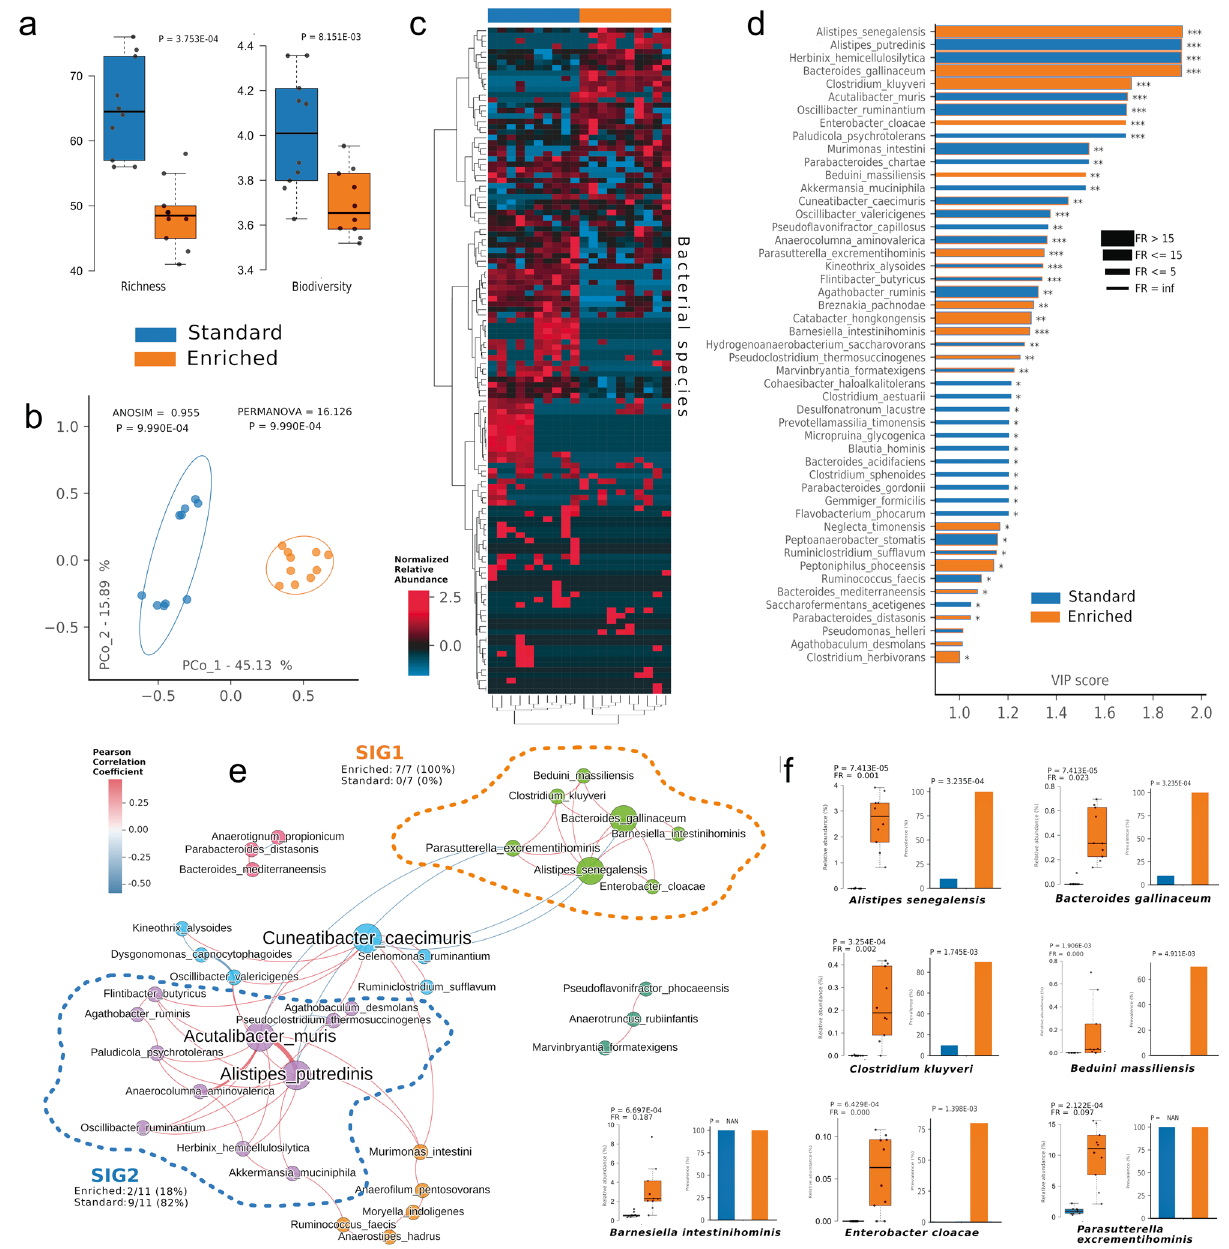
Fig. 1 Fecal microbiota composition in EE and SE mice. Alfa-diversity ( a ) shows differences in both richness (number of bacterial species) and biodiversity (Shannon metric) among standard (SE, blue, n = 10 biologically independent samples) and enriched mice (EE, orange, n = 10 biologically independent samples). Beta-diversity ( b ) and Hierarchical Clusterization Analysis (HCA, c ), following the Bray-Curtis dissimilarity distance algorithm, both show signi fi cant separation of SE and EE. Variable Importance Plot (VIP, d ) shows: (i) discriminant species after PLS-DA in descending order of VIP score (bar length); (ii) the highest relative abundance depending on the cohort (central bar color) and the lowest one (edge bar color); (iii) fold ratio (FR) of the highest vs the lowest relative abundance (bar thickness); (iv) signi fi cant difference after Mann – Whitney U test (non-FDR, * P ≤ 0.05, ** P ≤ 0.01; *** P ≤ 0.001). Network analysis ( e ) shows communities of bacterial species (namely species-interacting groups, SIGs) and their positive (red Pearson coef fi cient) or negative (blue Pearson coef fi cient) relative abundances correlation. Nodes are colored according to the cohort harboring the higher relative abundance for a de fi nite species, and node name size is directly proportional to the “ keystonness ” (importance of a species within the overall network). Edge thickness is inversely proportional to the Pearson P value after 10% Benjamini-Hochberg two-stages FDR, and it is colored according to positive (red) or negative (blue) Pearson coef fi cient. For each SIG are reported percentages of EE- and SE-related species. Pairwise analysis ( f ) of 7 selected species (belonging to EE-related SIG1) depicts signi fi cant differences in terms of relative abundance and prevalence when matched with SE cohort. In each sub- graph are reported the P value (from Mann – Whitney U test) and the fold ratio (FR) among SE and EE cohorts. The boxplots show the minimum, 25th percentile, median, 75th percentile, and maximum values. Error bars = SEM.